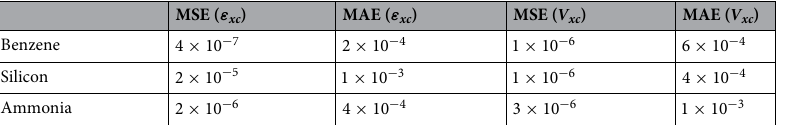
Table 1. MSE and MAE results for ε xc and V xc on a training dataset. The units of MSE are Ha 2 a 3 of MAE are Ha 0 . ×